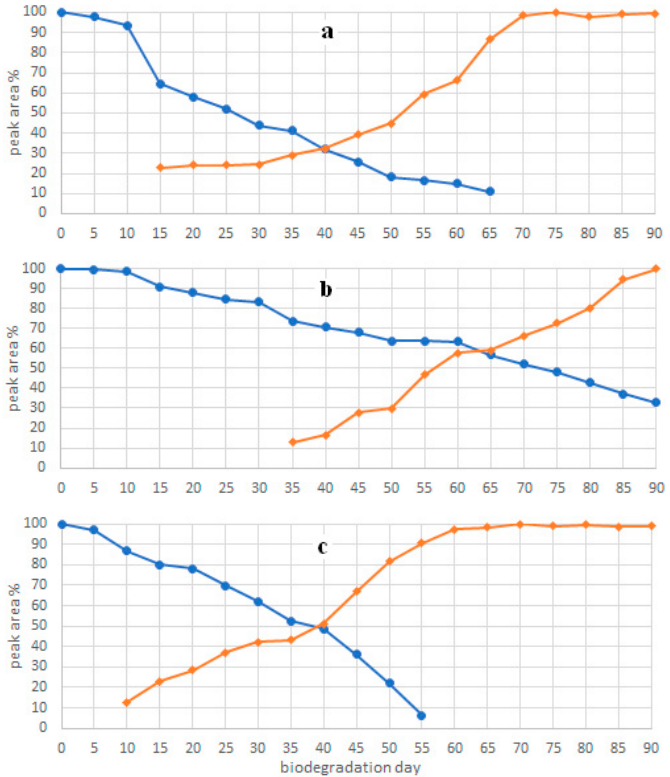
Figure 2. Exemplary breakdown plots of chromatographic peak areas (UV chromatogram at 280 nm) against days of biodegradation test bisphenol A (BPA) (BPA was added to water samples at 10 mg/L on day 0, BPA, Product 1): ( a ) Niepruszewo lake, summer; ( b ) Niepruszewo lake, spring; and ( c ) Warta river, spring.